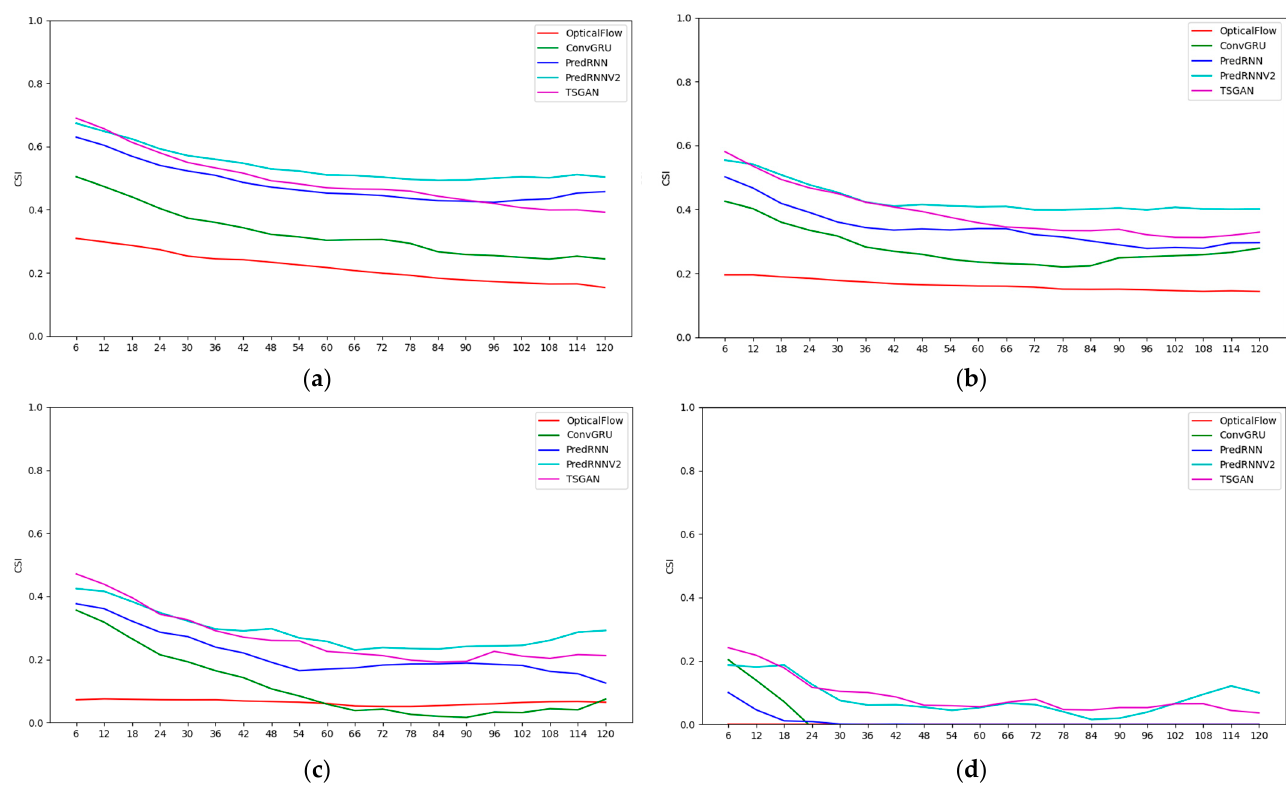
Figure 8. The scores of the critical success index for the forecasts of the squall line process. (a) 20 dBZ; (b) 30dBZ; (c) 40 dBZ; (d) 50 dBZ.